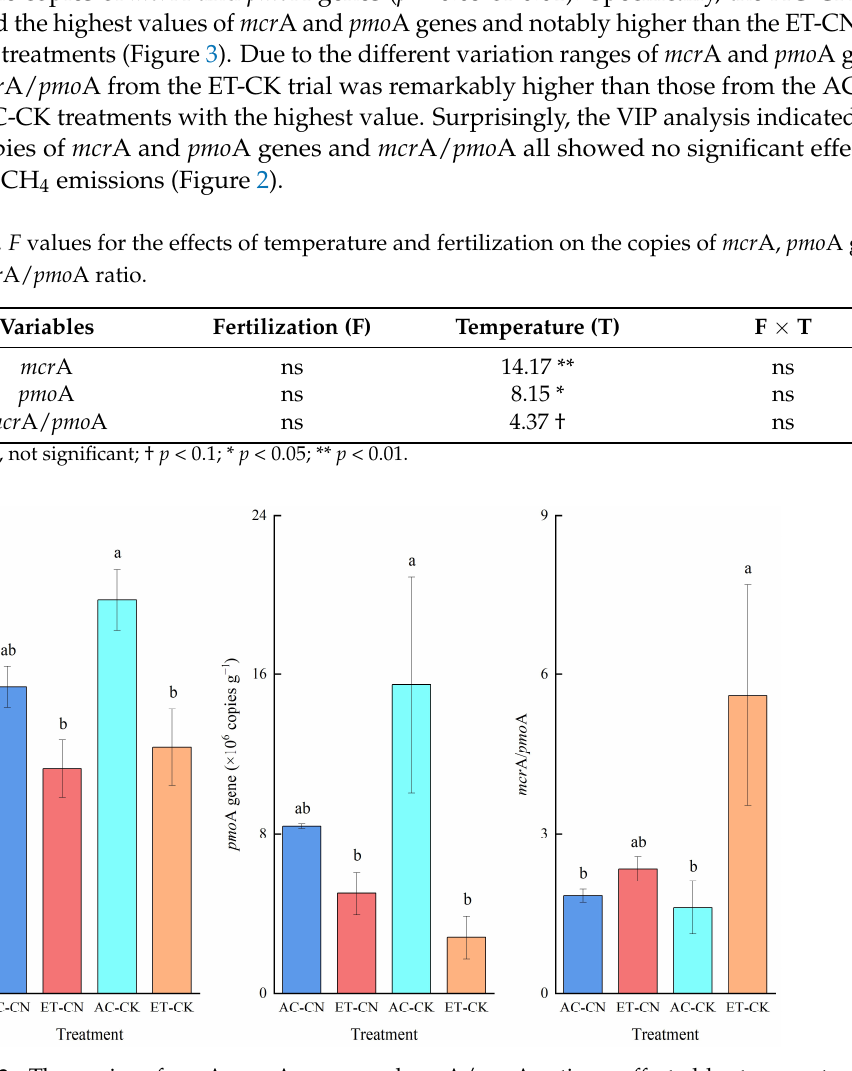
Table 2. Soil physicochemical properties as affected by temperature and fertilization.